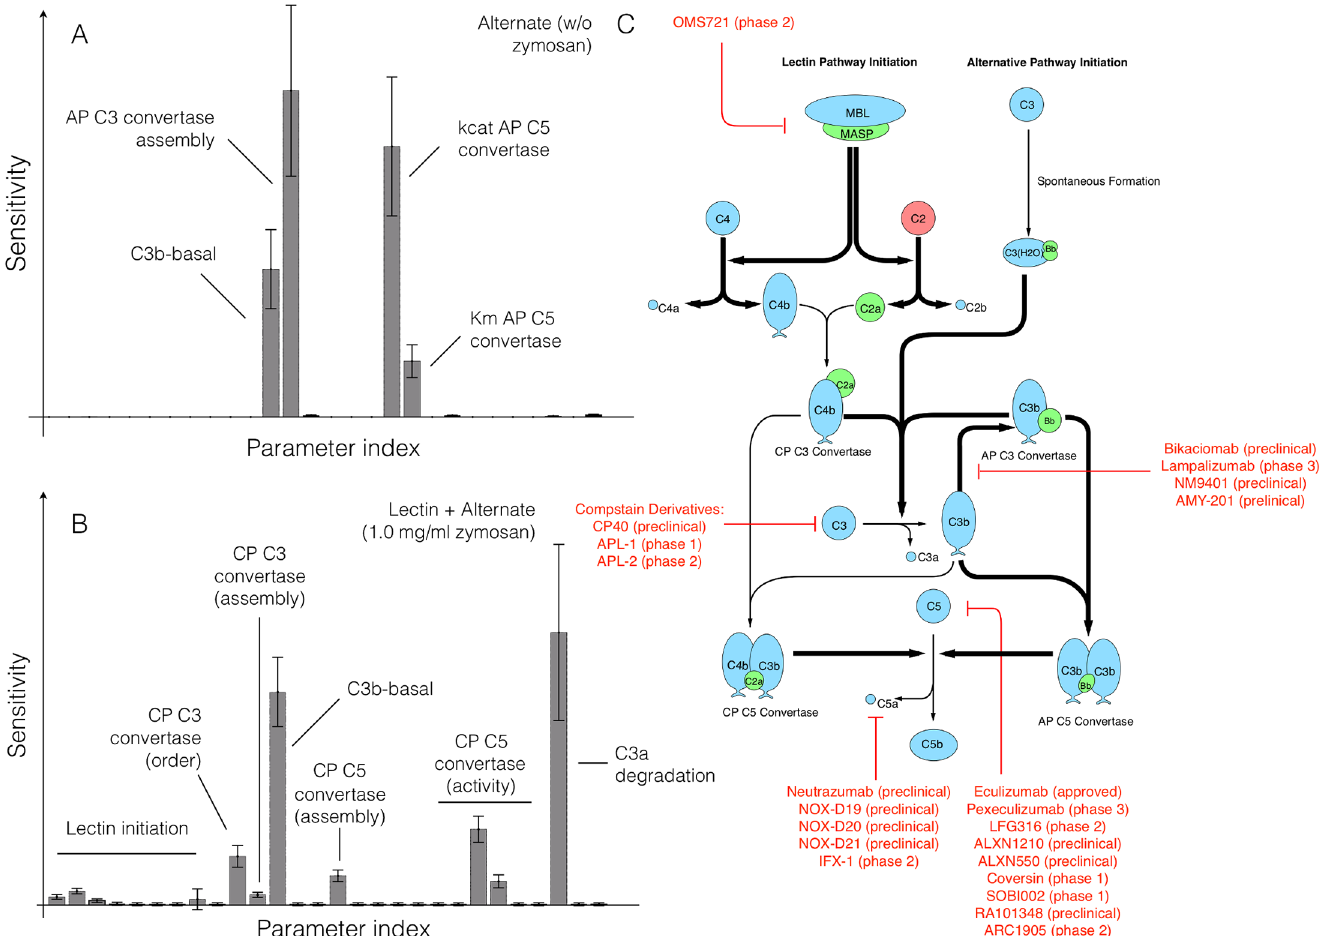
Fig 4. Global sensitivity analysis of the reduced order complement model. Sensitivity analysiswas conductedon the two objectivesused for model training. A : Sensitivity of the C3a and C5a residualw/o zymosan. B : Sensitivity of the C3a and C5a residual with 1 mg/ml zymosan. The bars denote the mean total sensitivity index for each parameter, whilethe error bars denote the 95% confidenceinterval. C : Pathways controlledby the sensitivity parameters. Bold black lines indicatethe pathway involvesone or more sensitive parameters, while the red lines show current therapeutics targets. Current complementtherapeutics were taken from the review of Morgan and Harris